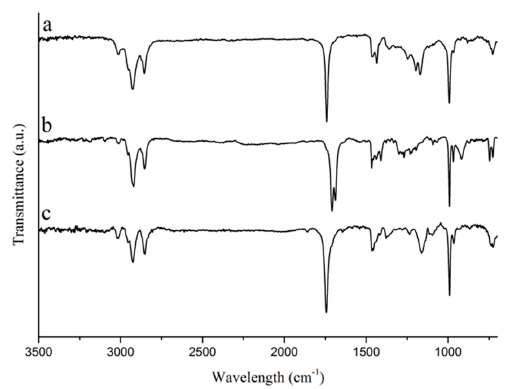
Figure 1. FTIR spectra of ( a ) tung oil methyl esters, ( b ) isolated α -eleostearic acid, and ( c ) tung oil.